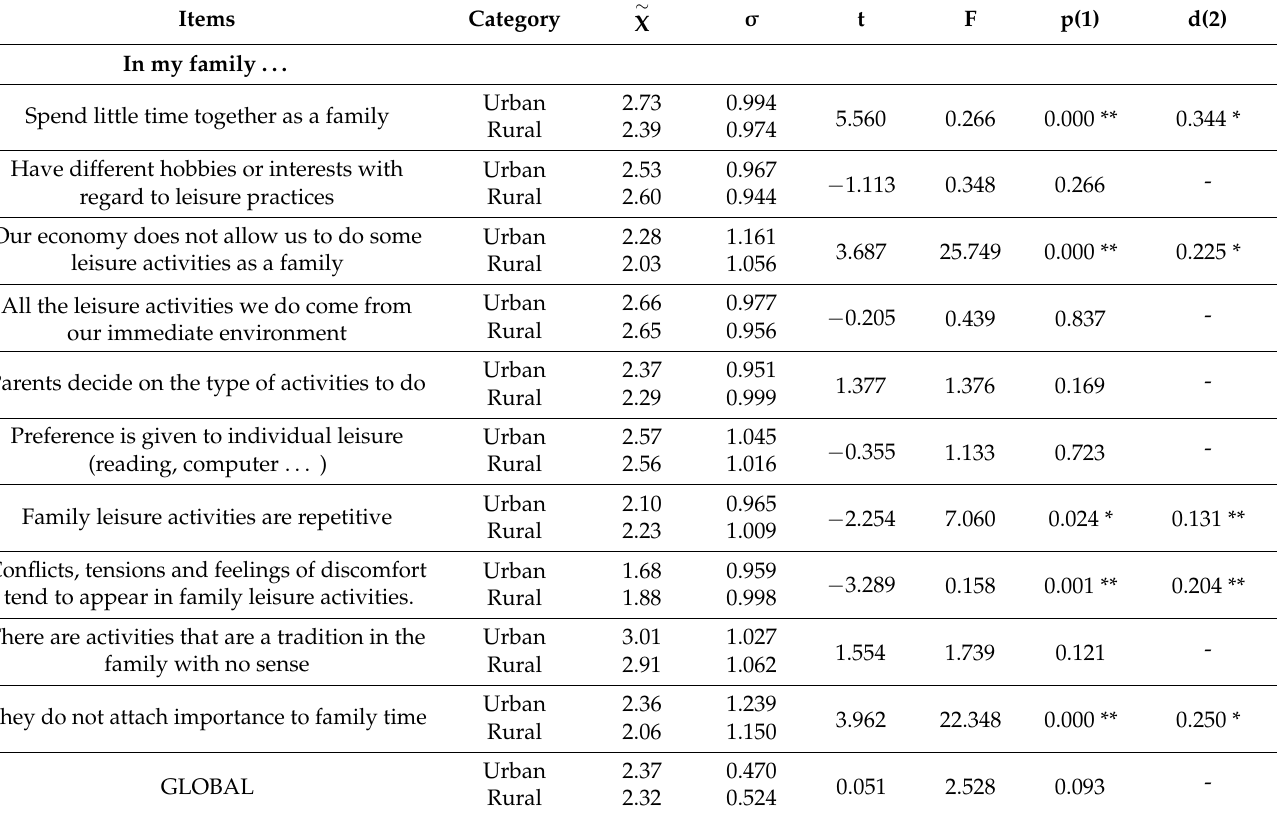
Table 2. Descriptive and inferential statistics of family leisure difficulties as a function of